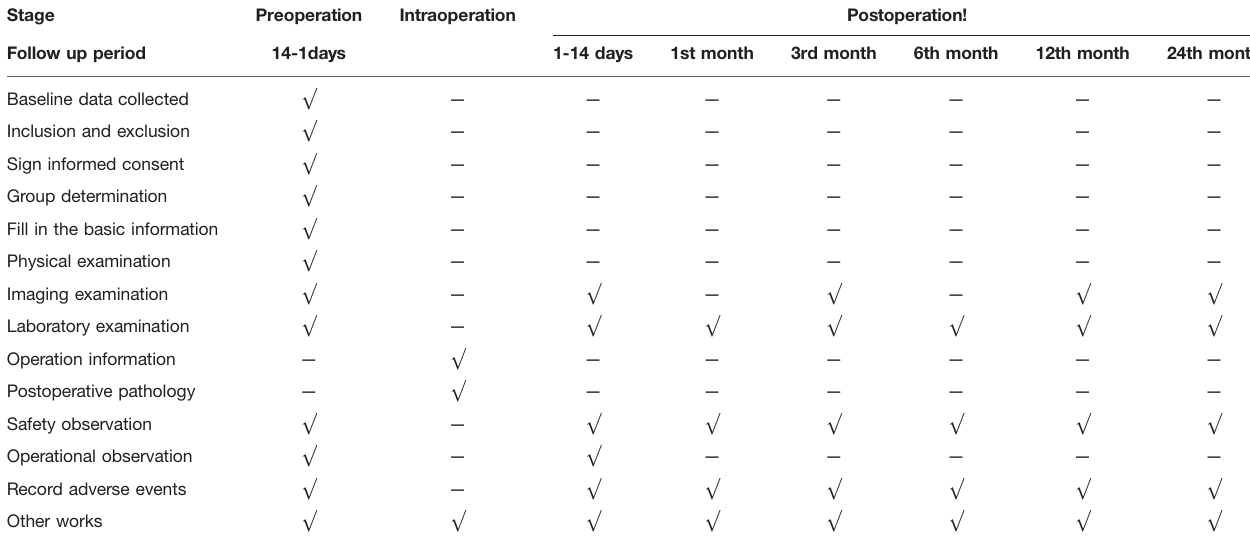
TABLE 2 | This is the content of each follow-up which are sorted and